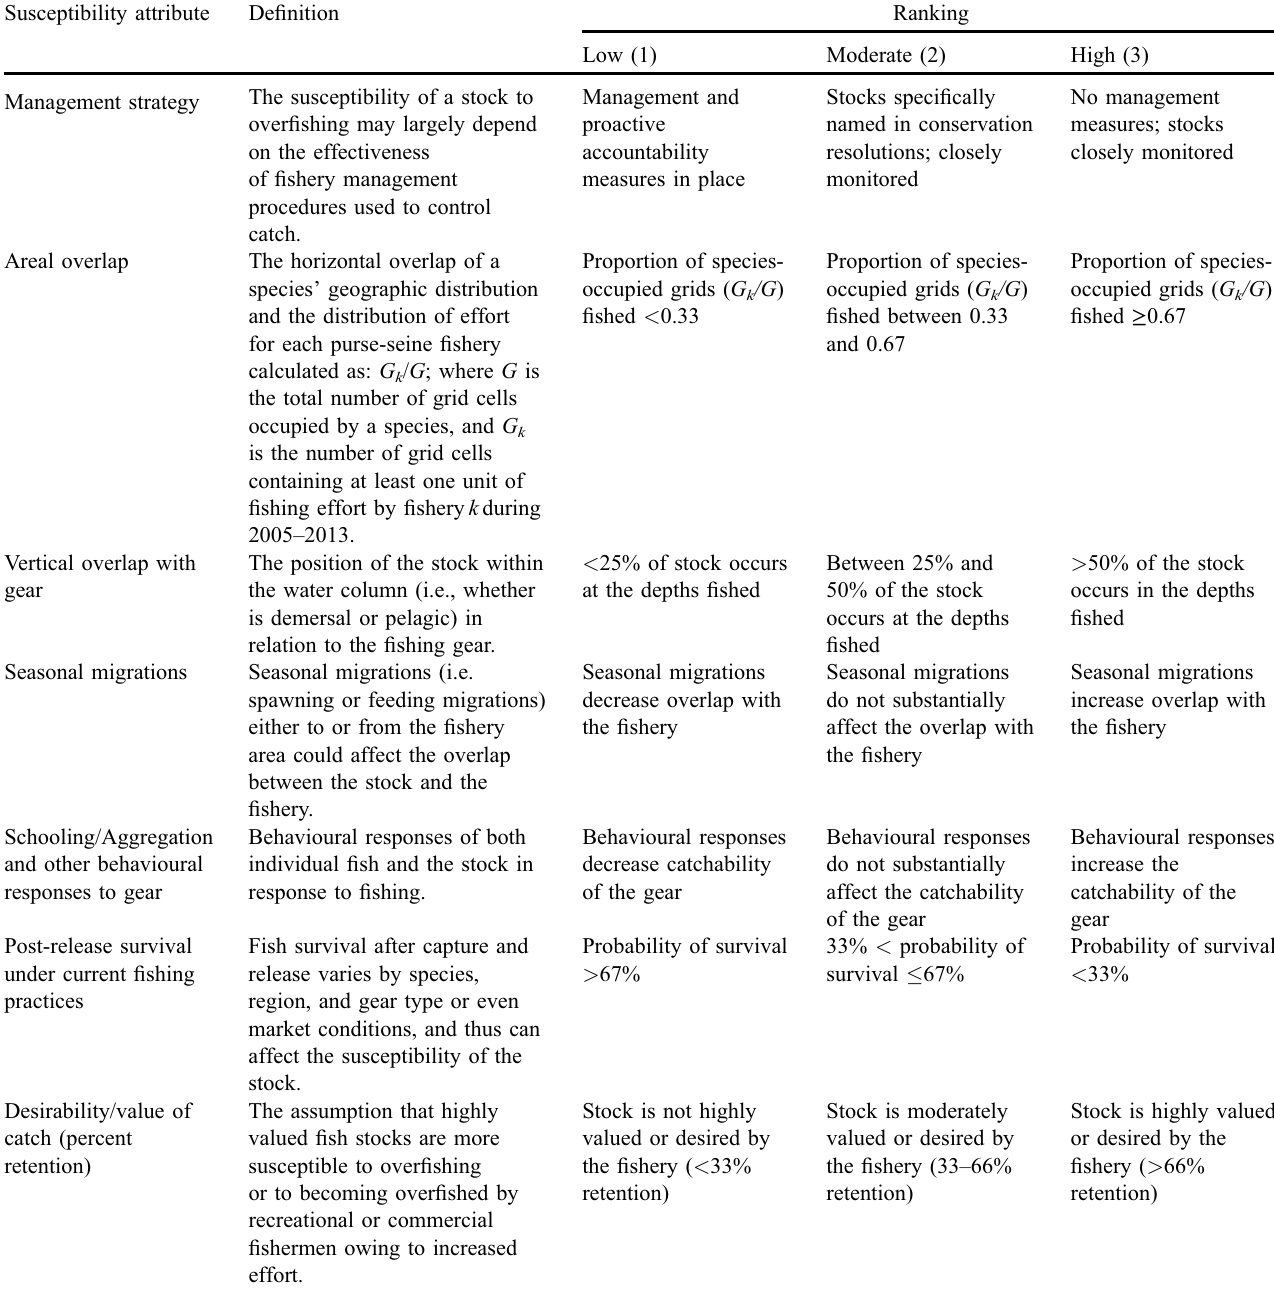
Table 2. Susceptibility attributes and scoring thresholds used in the example PSA of the eastern Paci fi c Ocean purse-seine fi shery (Duffy et al., 2019). Attribute de fi nitions taken from Table 2 in Patrick et al. (2010) with the exception of areal overlap taken from Grif fi ths et al.